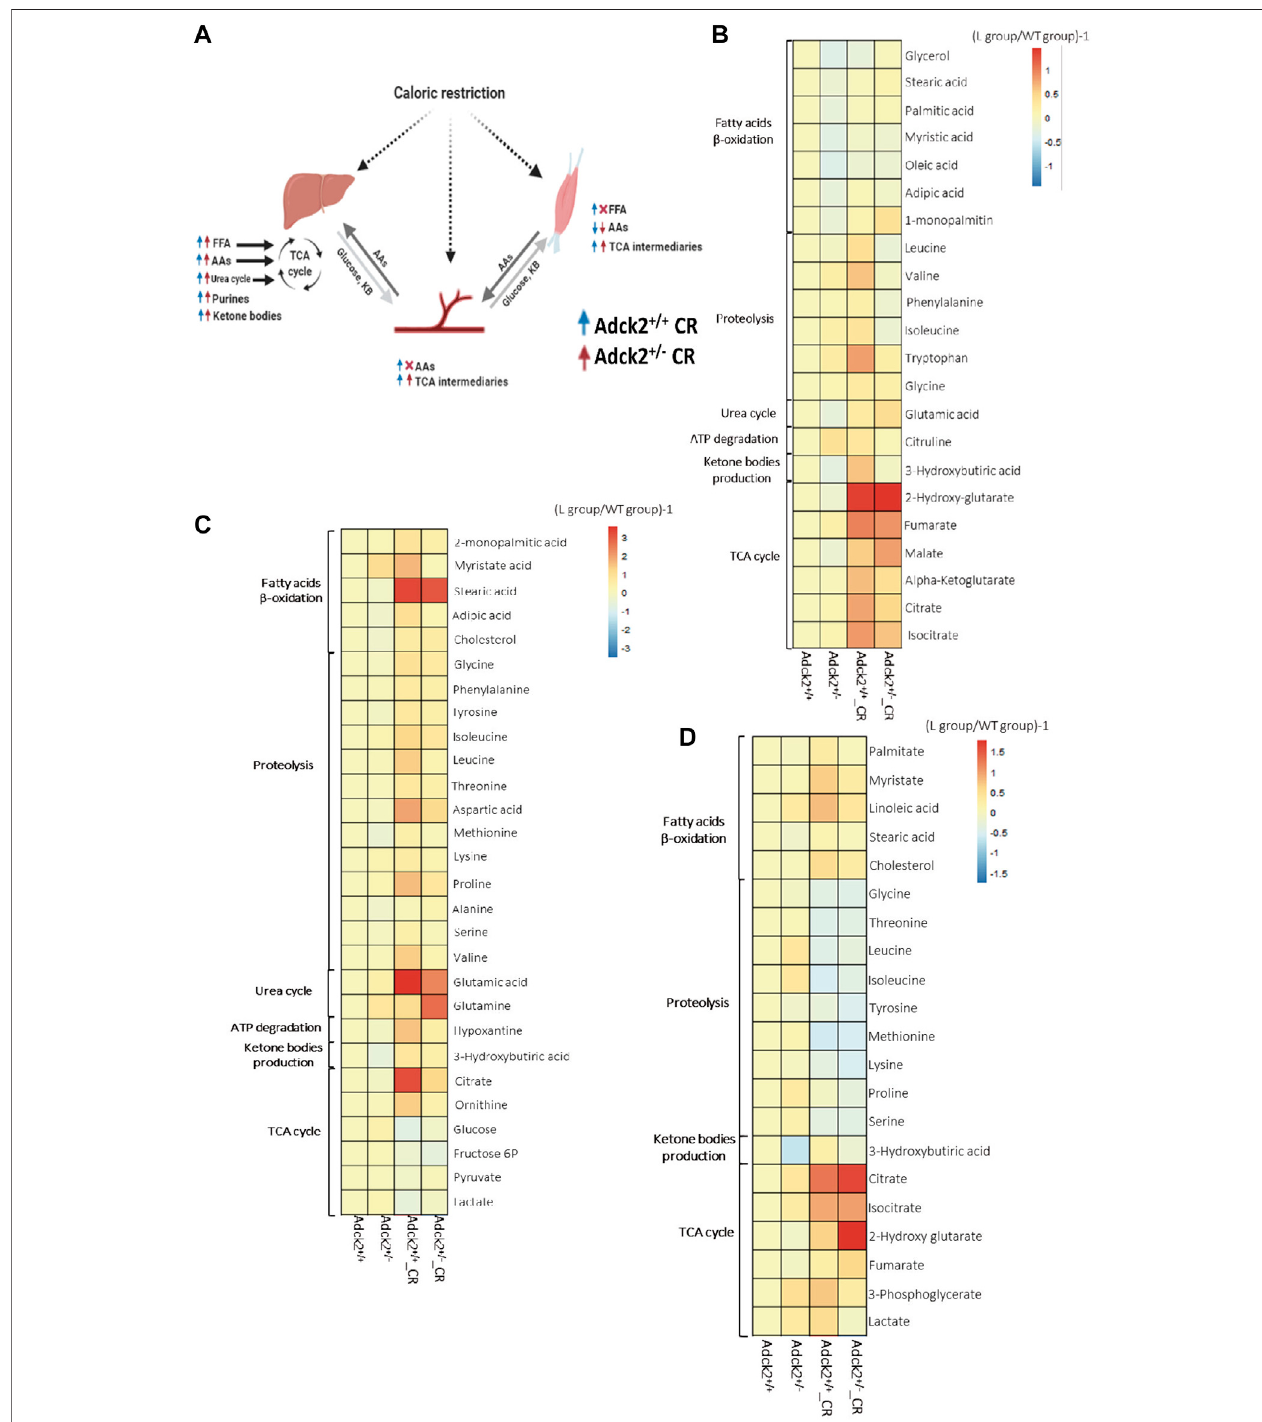
FIGURE 2 | Metabolic pro fi le in plasma, liver and muscle on calorie restriction conditions. (A) . Summary of the effects of calorie restriction on metabolomics. (B) . Metabolicpro fi leintheplasma.(Adck2 +/+ N=3,Adck2 +/ − N=3,Adck2 +/+ CRN=4,Adck2 +/ − CRN=4). (C) .Metabolicpro fi leinliver.(Adck2 +/+ N=4,Adck2 +/ − N=4, Adck2 +/+ CR N = 5, Adck2 +/ − CR N = 5). (D) . Metabolic pro fi le in skeletal muscle. (Adck2 +/+ N = 4, Adck2 +/ − N = 4, Adck2 +/+ CR N = 5, Adck2 +/ − CR N = 5). Statistics analyses are included in supplementary materials. CR, calorie restriction; FFA, free fatty acids; AAs, aminoacids; TCA, tricarboxylic cycle.